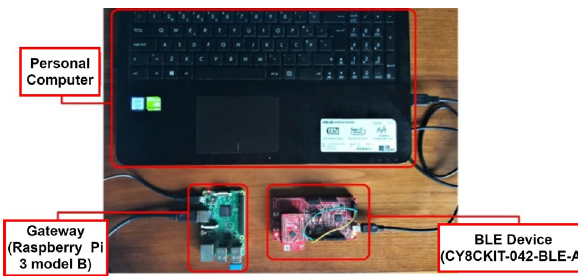
Figure 2. Main hardware components used in the development of the original smart home